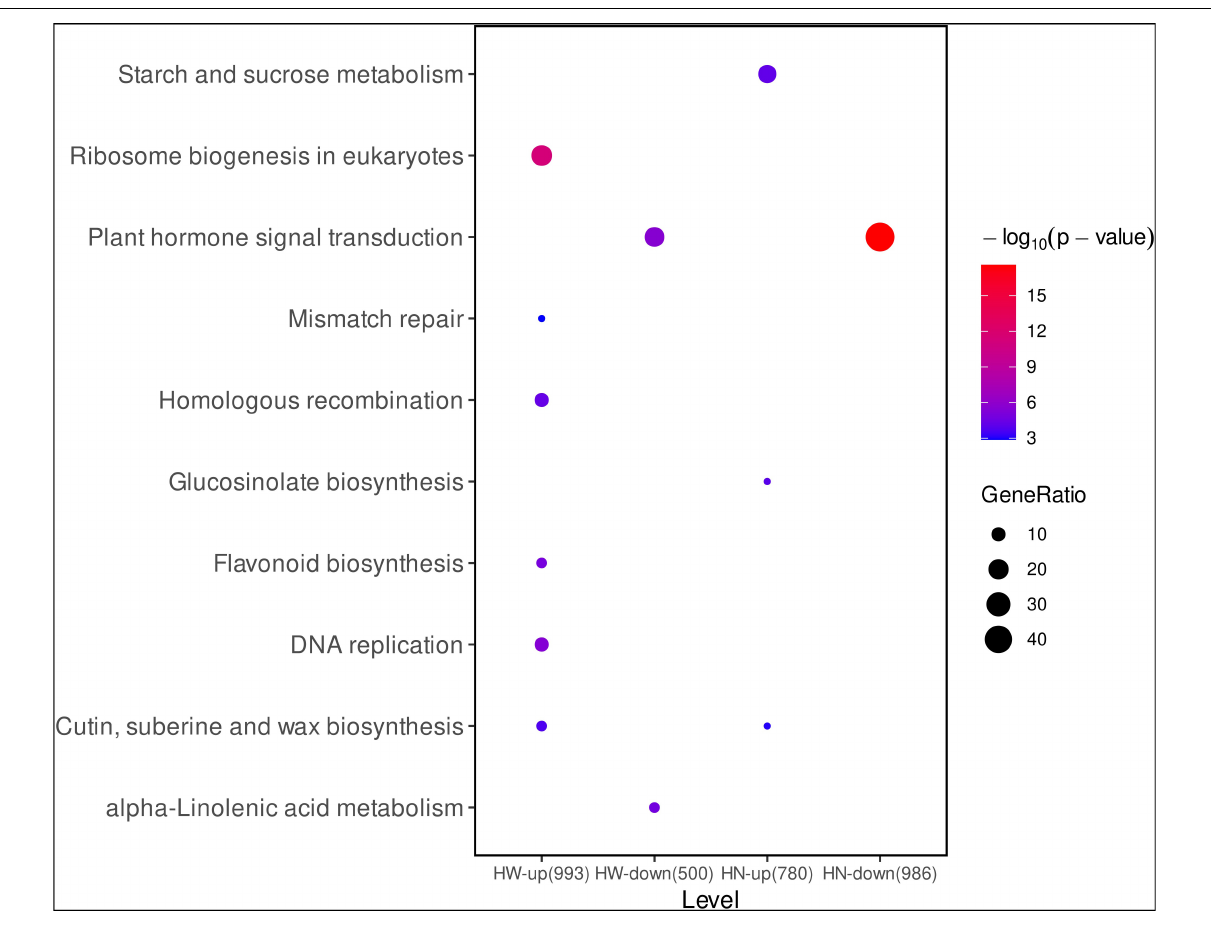
FIGURE 3 | The kyoto encyclopedia of genes and genomes (KEGG) pathway of DEGs. The pathway names are provided on the vertical axis. The color of the dot represents p value and the size of dot represents gene ratio in each functional category. The rich level in the horizontal axis is the size of the point, which represents the number of DEGs, and the color of the dot represents the q value. HW-up (993), 993 up-regulated DEGs in HW vs. WW; HW-down (500), 500 down-regulated DEGs in HW vs. WW; HN-up (780), 780 up-regulated DEGs in HN vs. WW; HN-down (980), 980 down-regulated DEGs in HN vs.